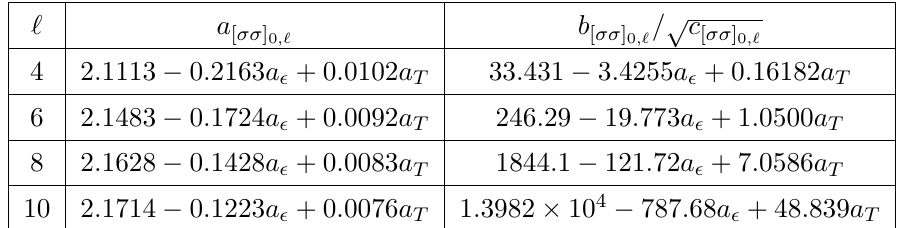
Table 1. The thermal coe(cid:14)cients and one-point functions for operators in the [ (cid:27)(cid:27) ] 0 family, a p and, b = c respectively. Both coe(cid:14)cients are shown in terms of the unknown thermal [ (cid:27)(cid:27) ] 0 ;‘ [ (cid:27)(cid:27) ] 0 ;‘ coe(cid:14)cients a (cid:15) and a T and include self-corrections from operators in the [ (cid:27)(cid:27) ] 0 family and are shown in the normalization in which f is positive. While in this paper we have not determined a (cid:27)(cid:27) [ (cid:27)(cid:27) ] 0 ;‘